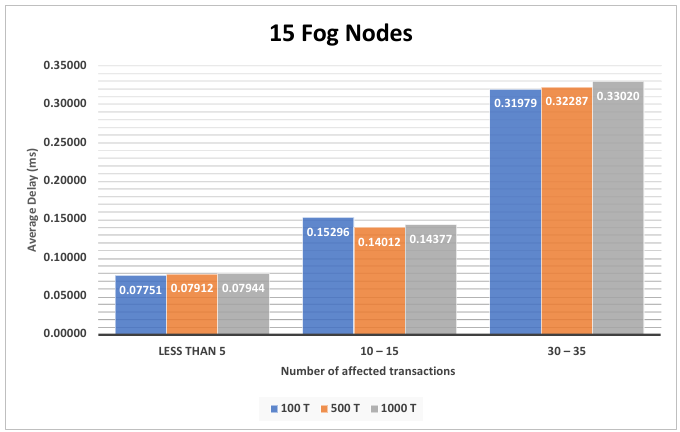
Figure A12. The impact of different number of transactions on 15 fog nodes.